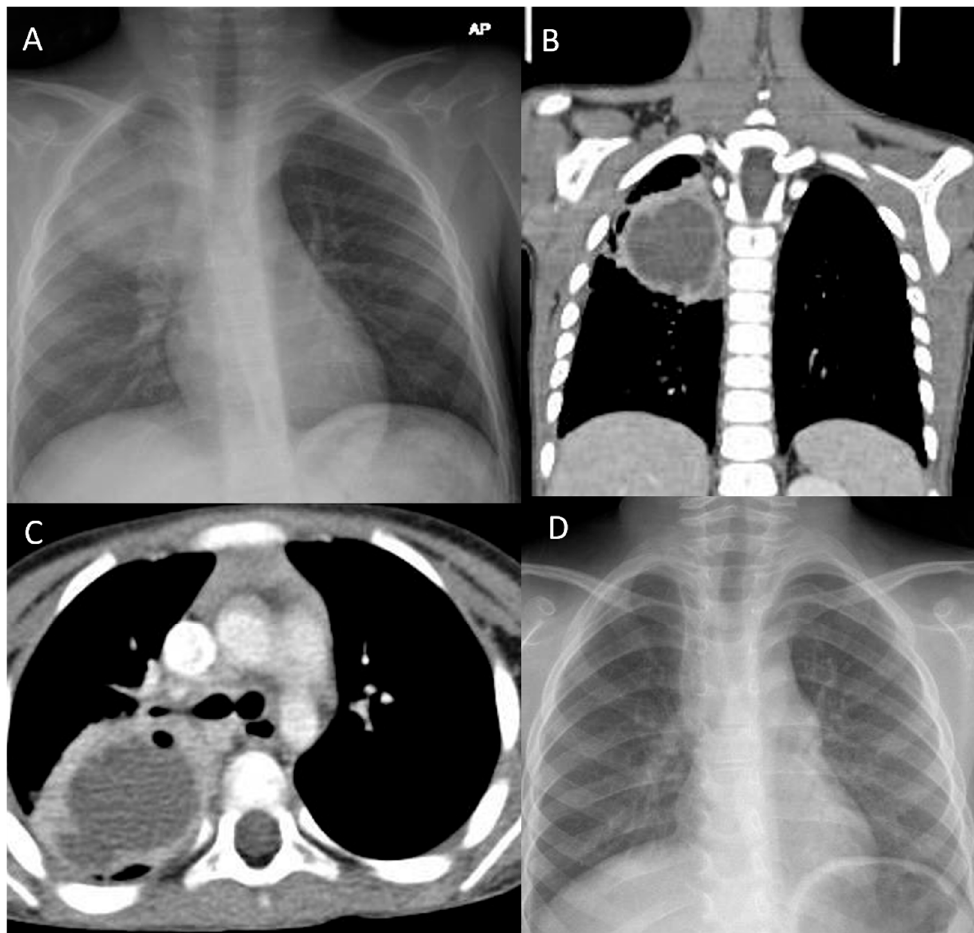
Figure 4. Chest X-ray (CXR) and chest computed tomography (CT) findings in case 5: ( A ) CXR of the patient on admission shows opacification involving the right upper lobe. ( B , C ) Coronal and axial windows, mediastinal view; CT scan of the chest shows a large, thick-walled cavity filled with fluids with heterogeneous opacity occupying the right upper lobe, leading to pleural and chest wall adhe- sions. ( D ) CXR of the patient at the 5-month postoperative follow-up shows well-aerated lung with- out any consolidations or air leakage.